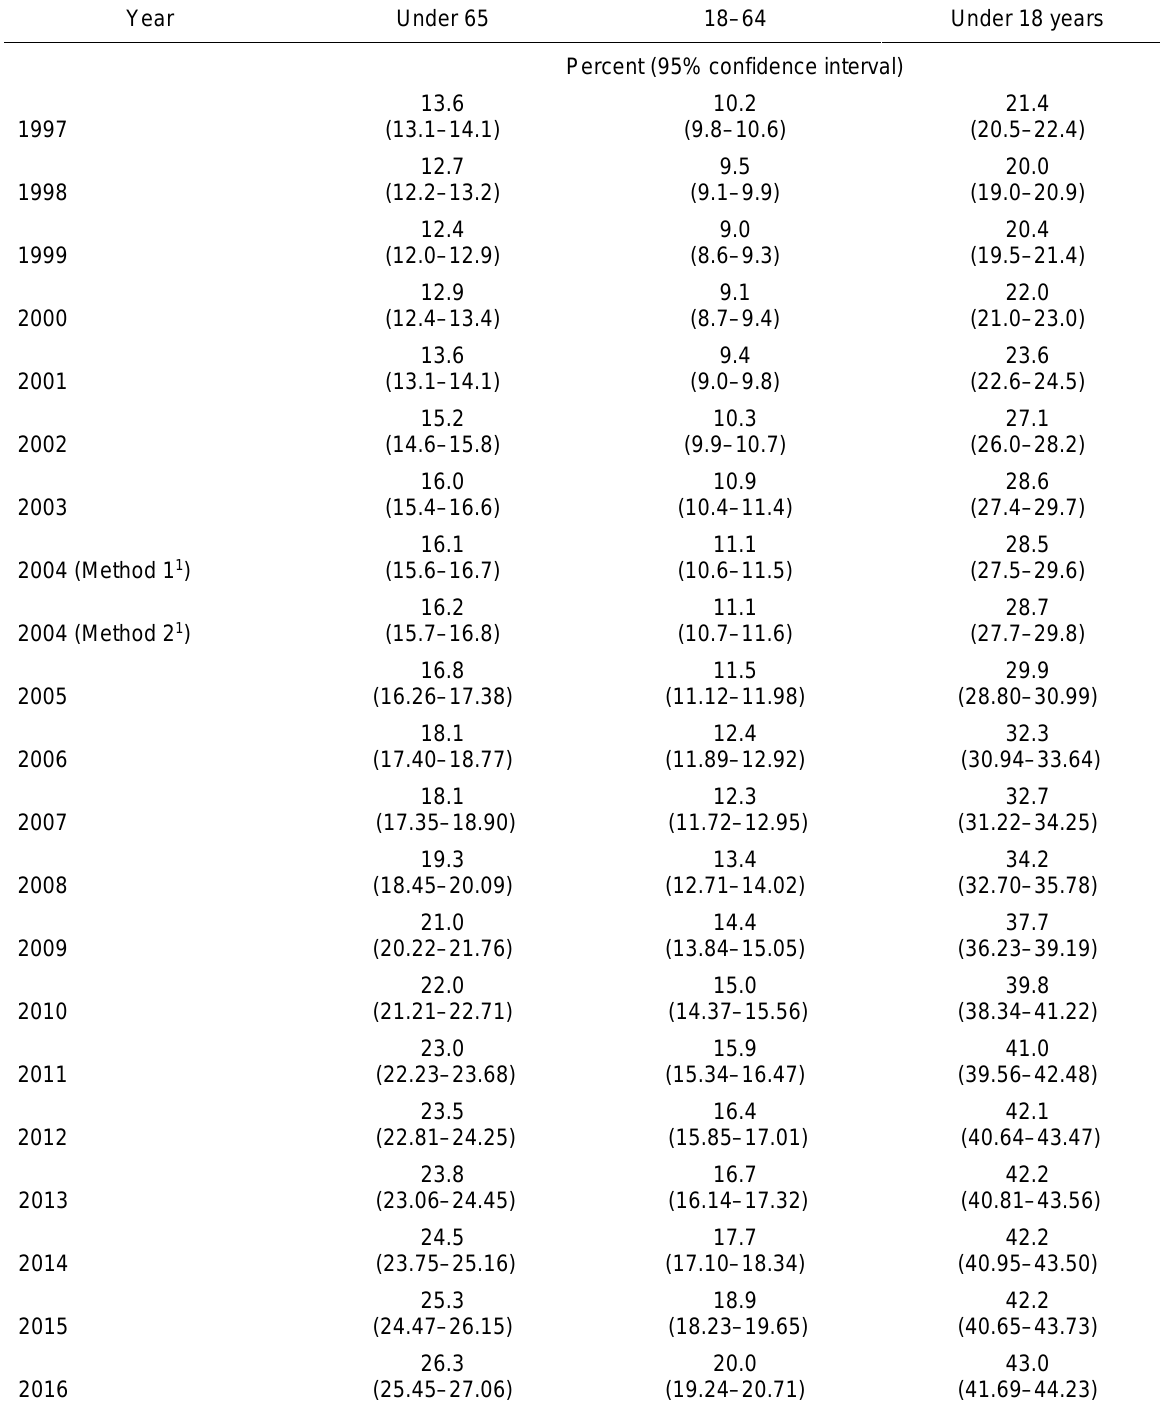
Table 1.2a. Percentage of persons under age 65 with public health plan coverage, by age group: United States,